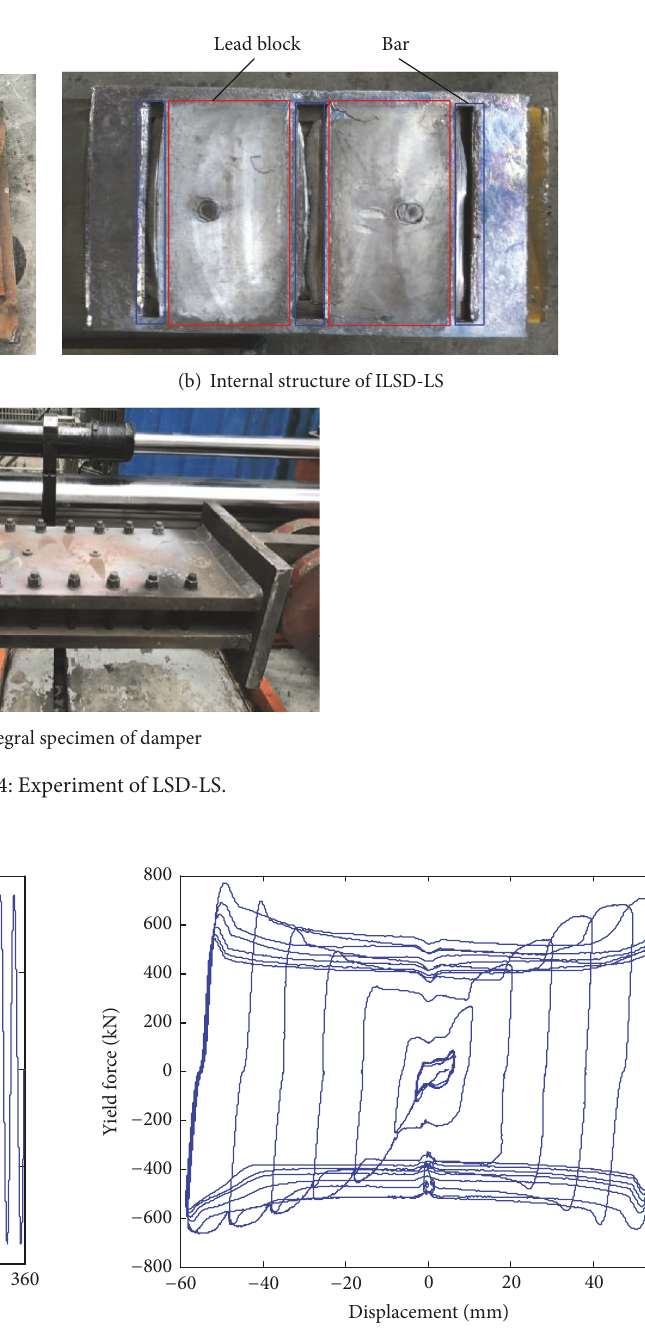
Figure 15: Loading history. Figure 16: Experiment result of